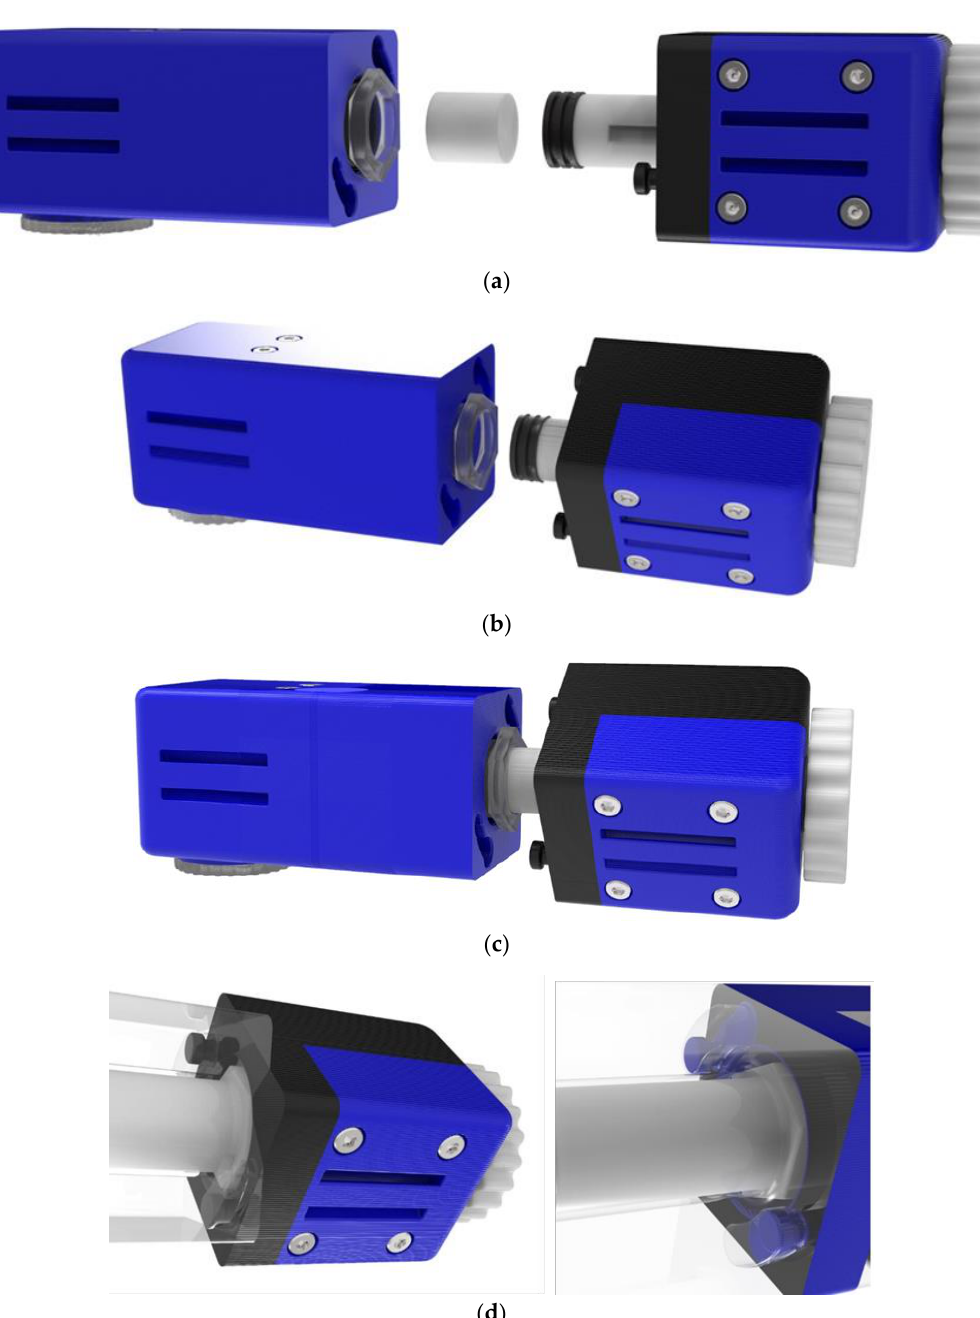
Figure 5. ( a ) Functional illustration of the mechanism and placement of the gel containing the active substance; ( b ) preparation for connection of A and B sub-assemblies; ( c ) pins joining with the cylindrical sockets and coincidence of the surfaces of the two parts; ( d ) rotation and lock of mechanism.